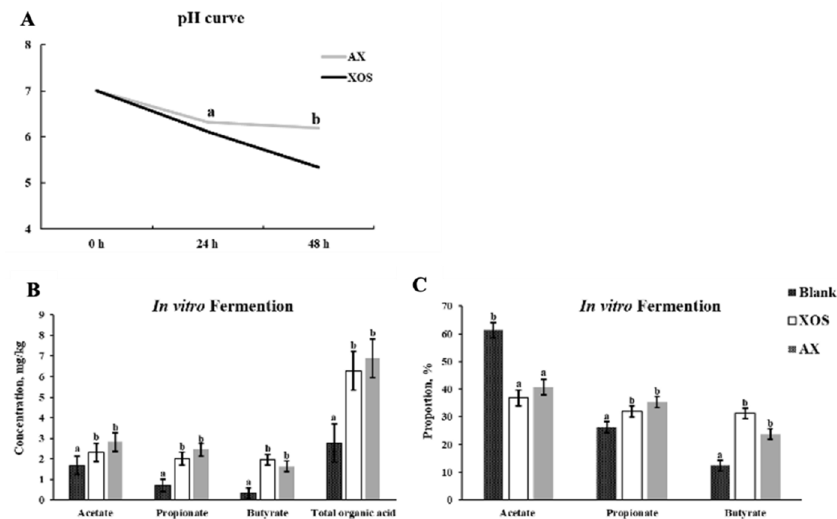
Figure 7. Effects of in vitro fermentation of xylo-oligosaccharides and arabinoxylans on pH and SCFA concentrations. Note: ( A ) pH; ( B ) in vitro fermentation of SCFA concentration; ( C ) in vitro fermentation of SCFA proportion. a, b Significant differences ( p < 0.05) between different letters in the same row of shoulder labels (n = 6); XOS, xylo-oligosaccharide; AX, arabinoxylans; SEM, standard error of the mean.